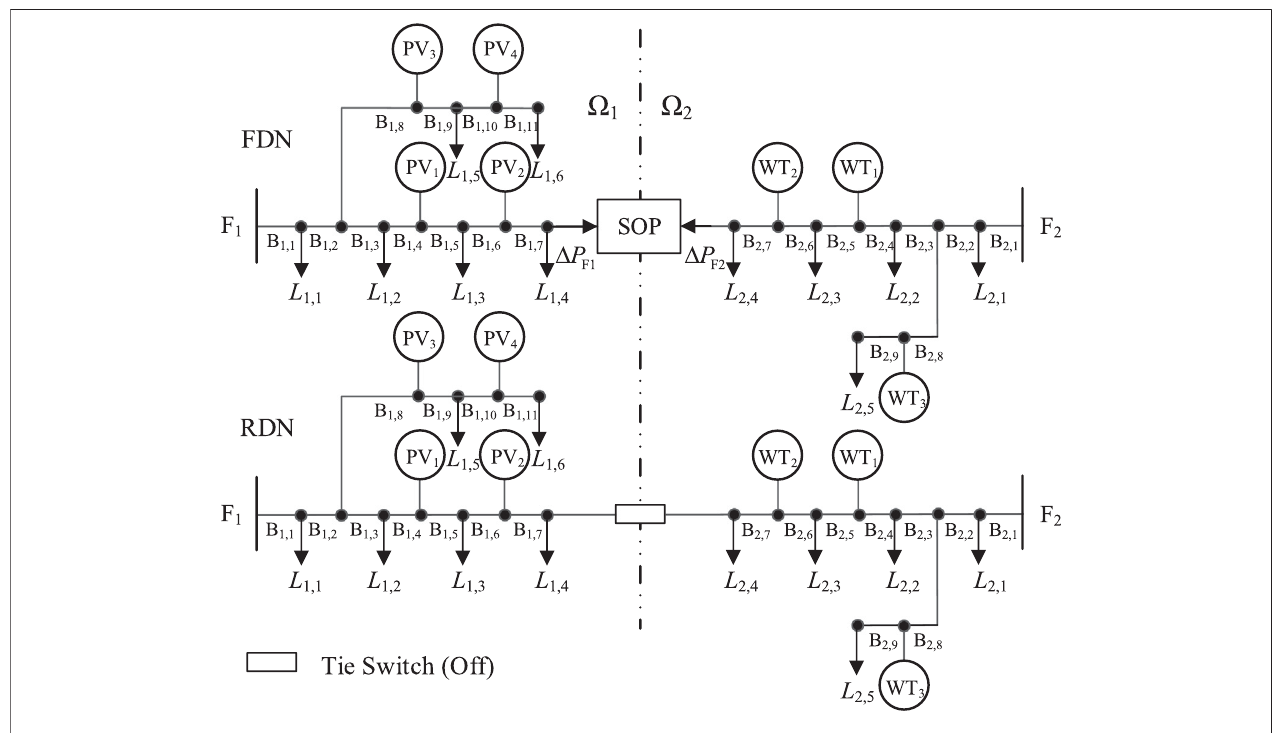
FIGURE 3 | Case grid of the FDN and RDN.